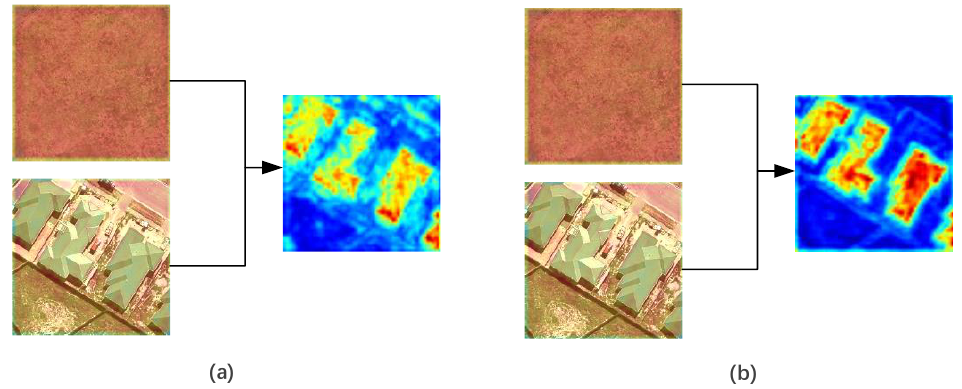
Figure 3. ( a ) Difference feature maps extracted with the absolute value. ( b ) Difference feature maps extracted with ASPP3d .